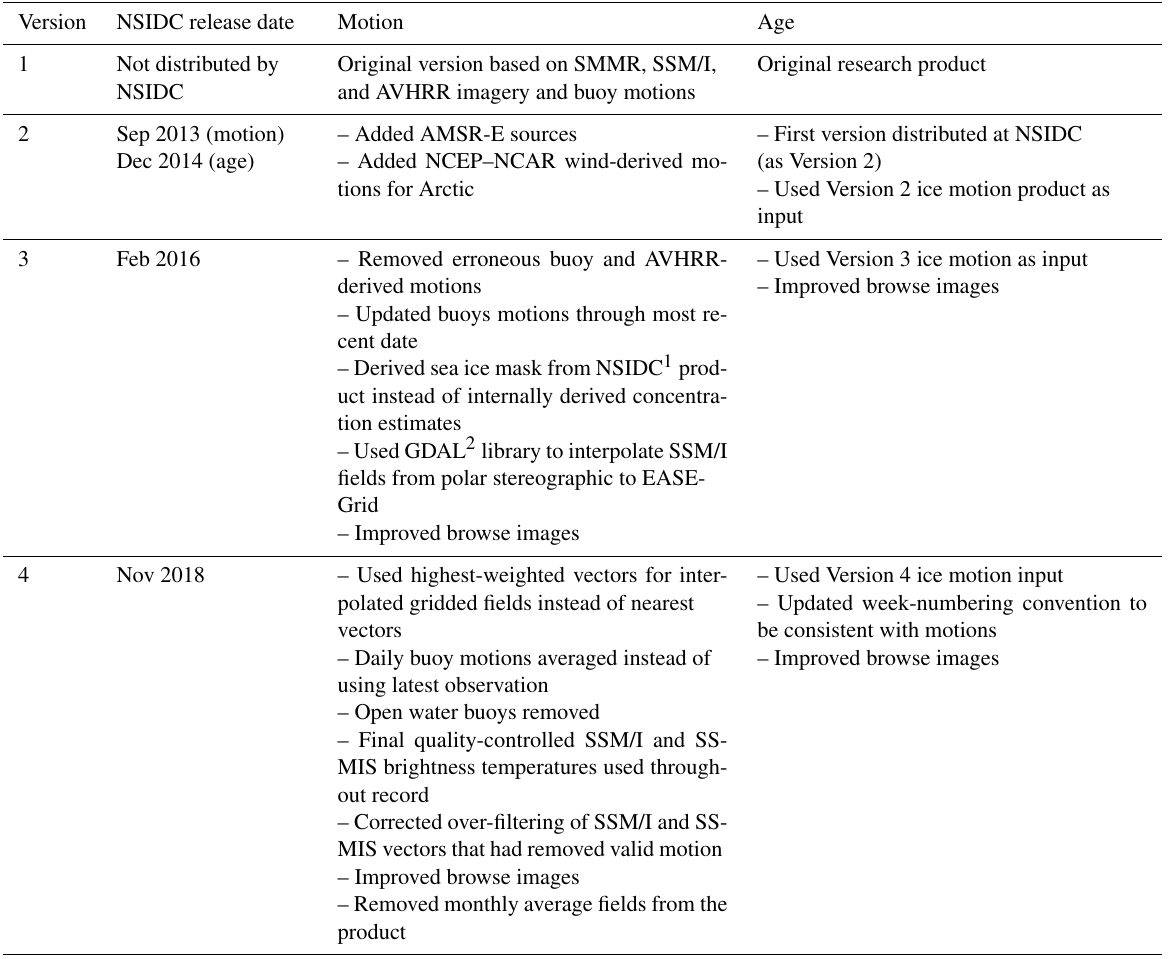
Table 1. Version histories of the sea ice motion and age